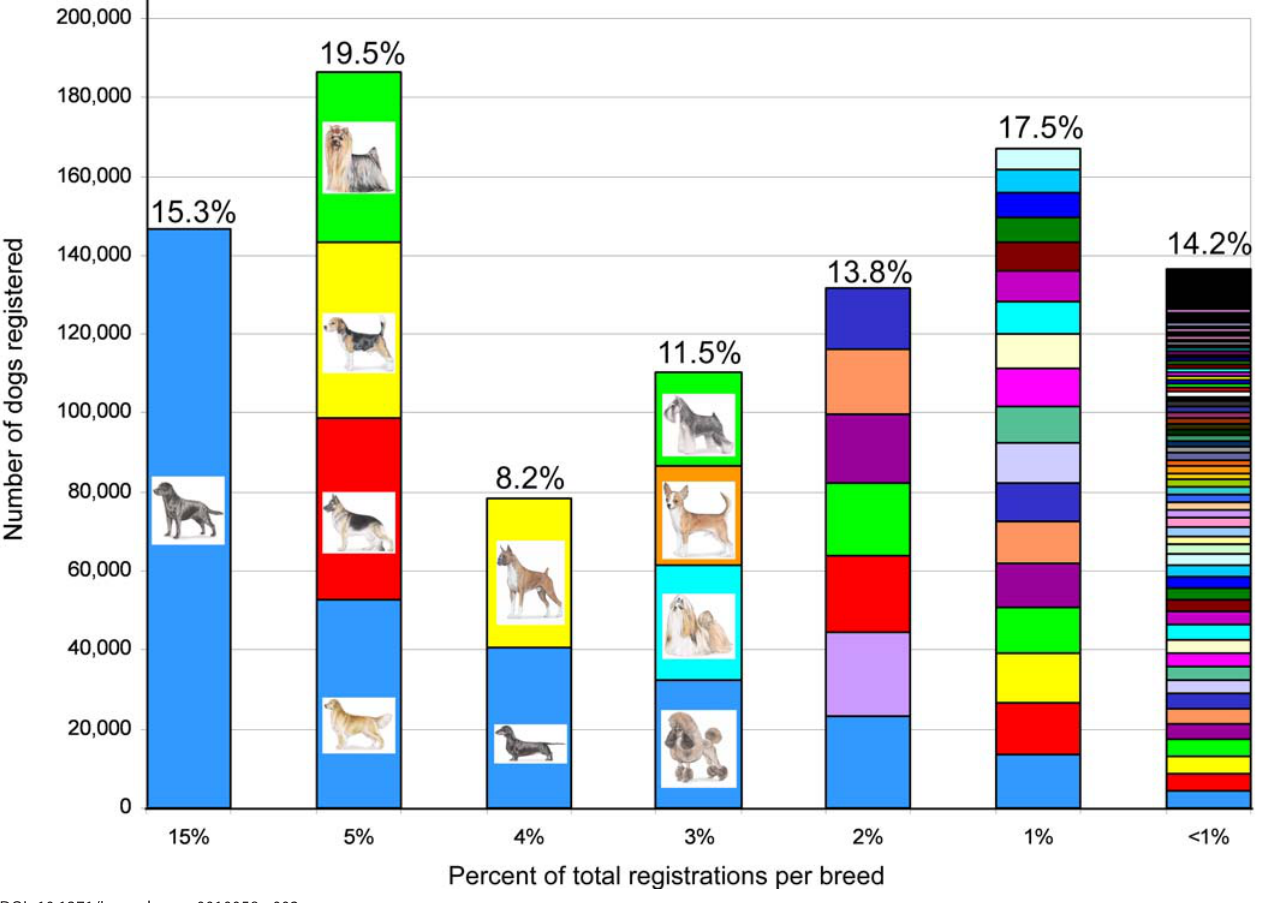
Figure 2. Distribution of American Kennel Club Registrations by Breed in 2004 Nearly a million dogs are registered with the American Kennel Club each year. Though the total includes dogs from 154 breeds, most registrations represent a limited number of very popular breeds. The most popular breed, Labrador retriever, accounts for 15.3% of yearly registrations. This is greater than the 118 least popular breeds combined. Each breed on the chart above is represented by a colored block. The height on the y-axis indicates the number of dogs registered in 2004. The blocks are divided into six stacks indicating the percent of overall registrations acquired by that breed, as listed on the x-axis. Above each column is the percent of total registrations for all breeds in that category. Registration statistics can be found at http://www.akc.org/reg/dogreg_stats.cfm.